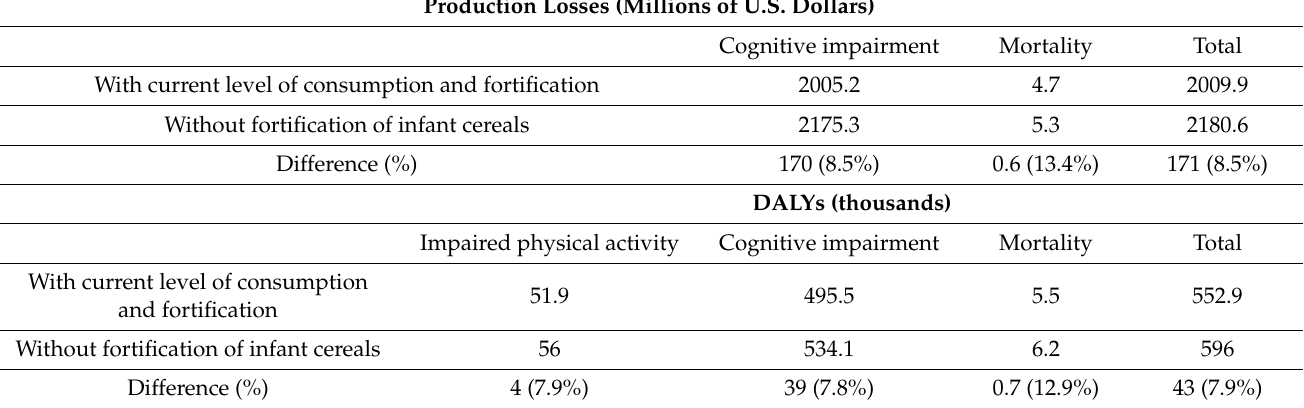
Table 2. Impact of the consumption of fortified infant cereals versus non-consumption on the burden of IDA in infants and young children aged 6–23